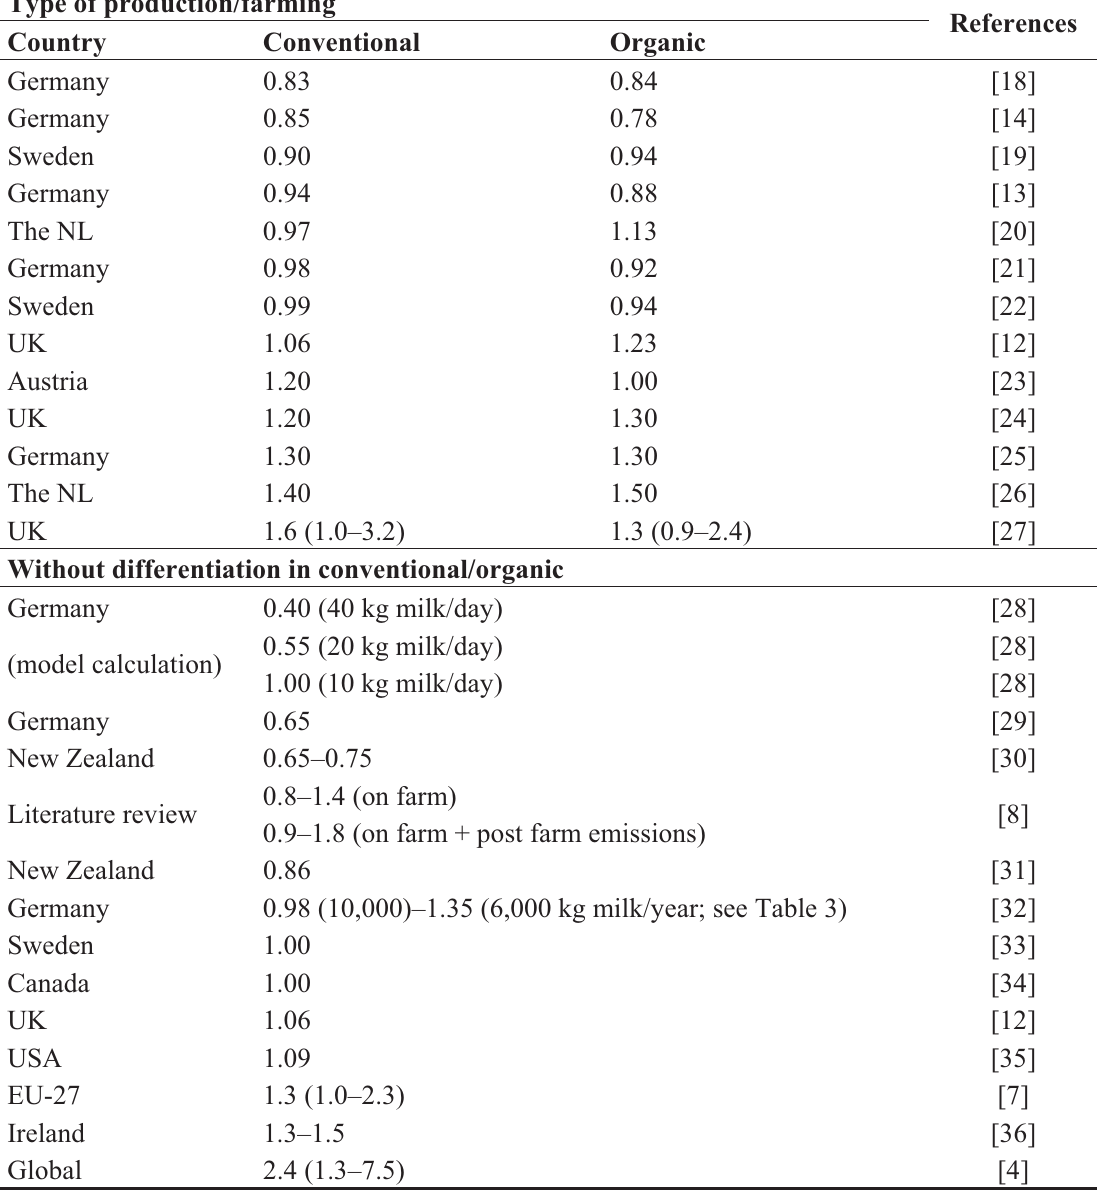
Table 1. Examples of Carbon Footprints (CF) (kg CO of